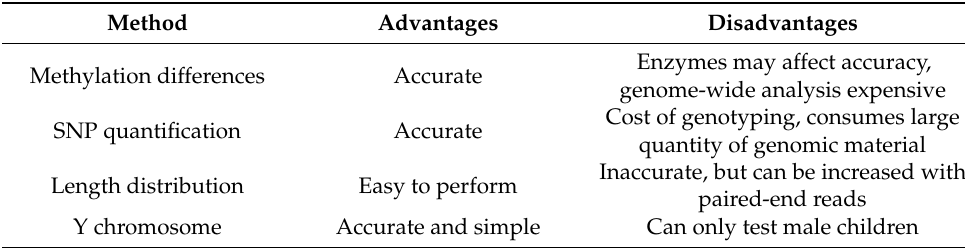
Table 4. Overview of different FF quantification methods. Method